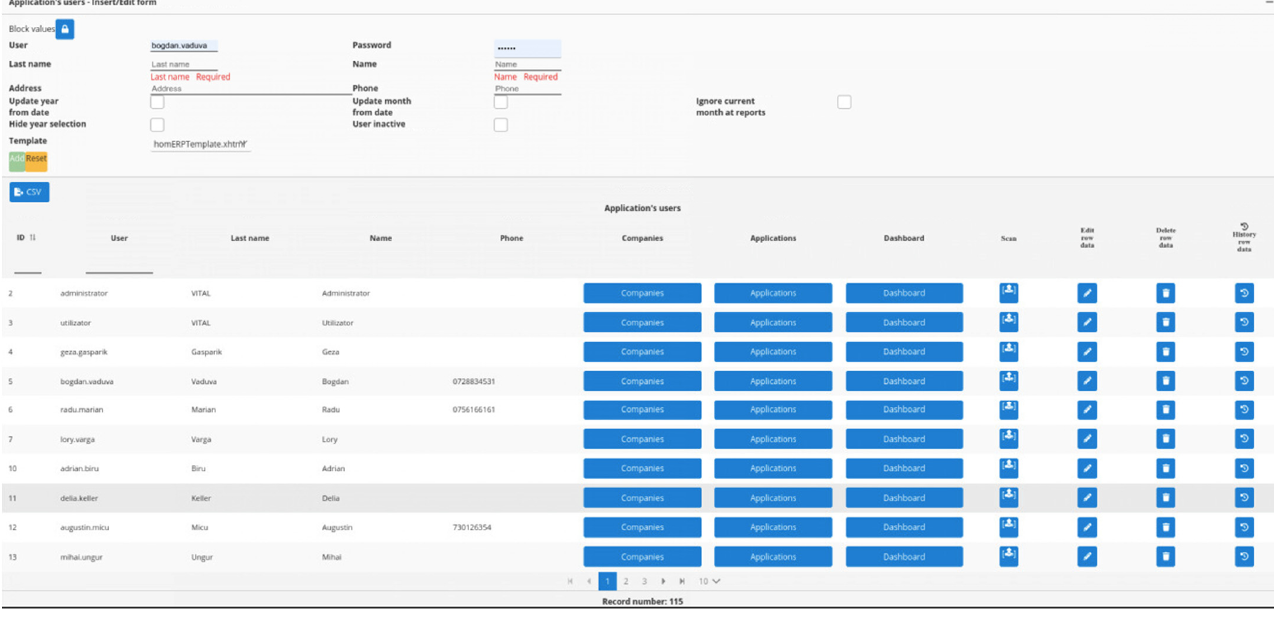
Figure 9. JavaScript/Angular 2+ “one4all” framework example—default view.